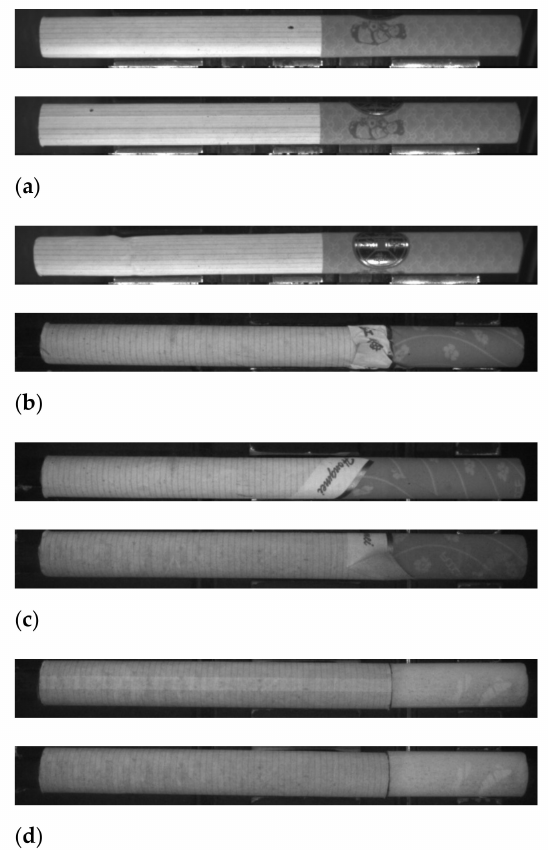
Figure 8. Defective cigarette types: ( a ) dotted cigarettes; ( b ) folded cigarettes; ( c ) malposed cigarettes; ( d ) unfiltered